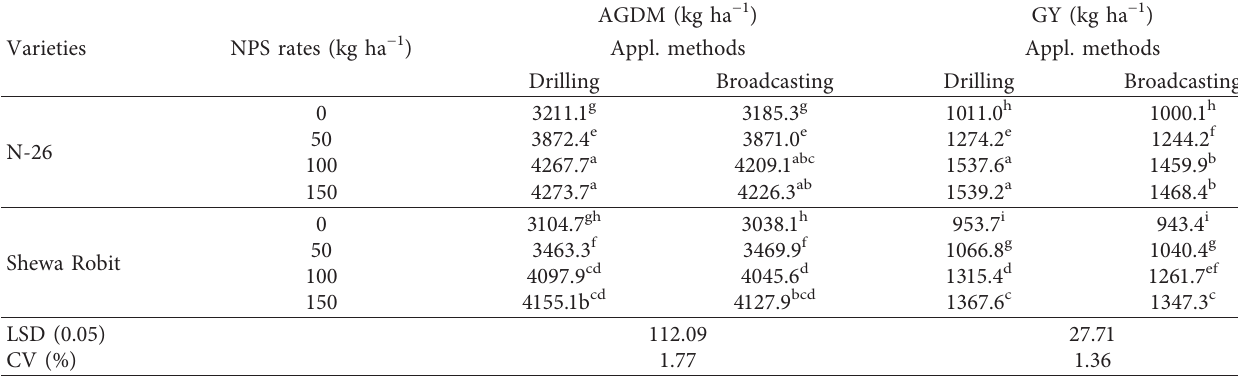
Table 4: Interaction effects of varieties, blended NPS fertilizer rates, and application methods on aboveground dry biomass (kg) and grain yield (g).